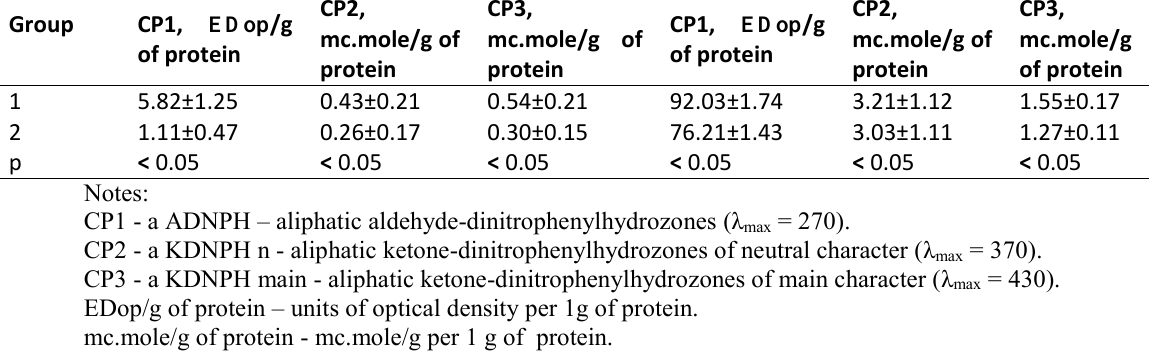
Table 2. Content of carbonyl proteins (CP) (level of proteins’ oxidative modification) in both groups (М±m) Group